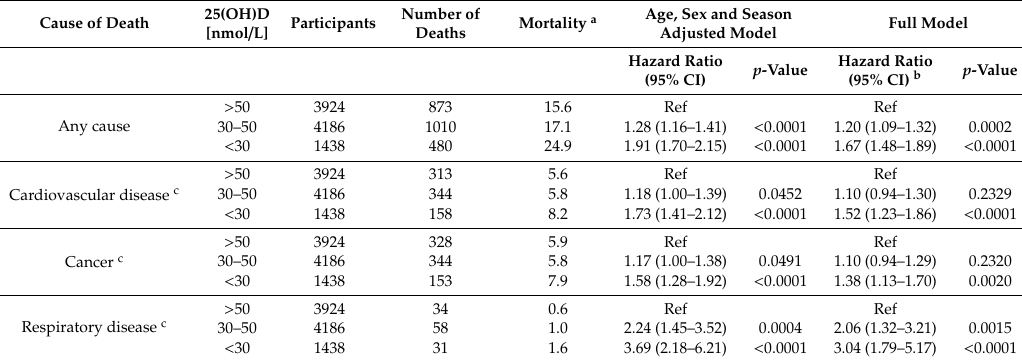
Figure 3. Dose–response relationship between 25(OH)D levels and respiratory disease mortality. Table 2. Mortality from major causes of death among people with vitamin D deficiency and insu ffi ciency compared to people with su ffi cient vitamin D